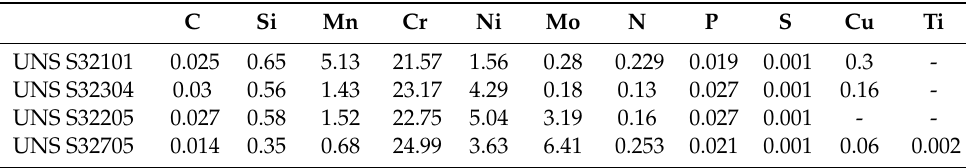
Table 1. Chemical composition of the studied materials (%wt).